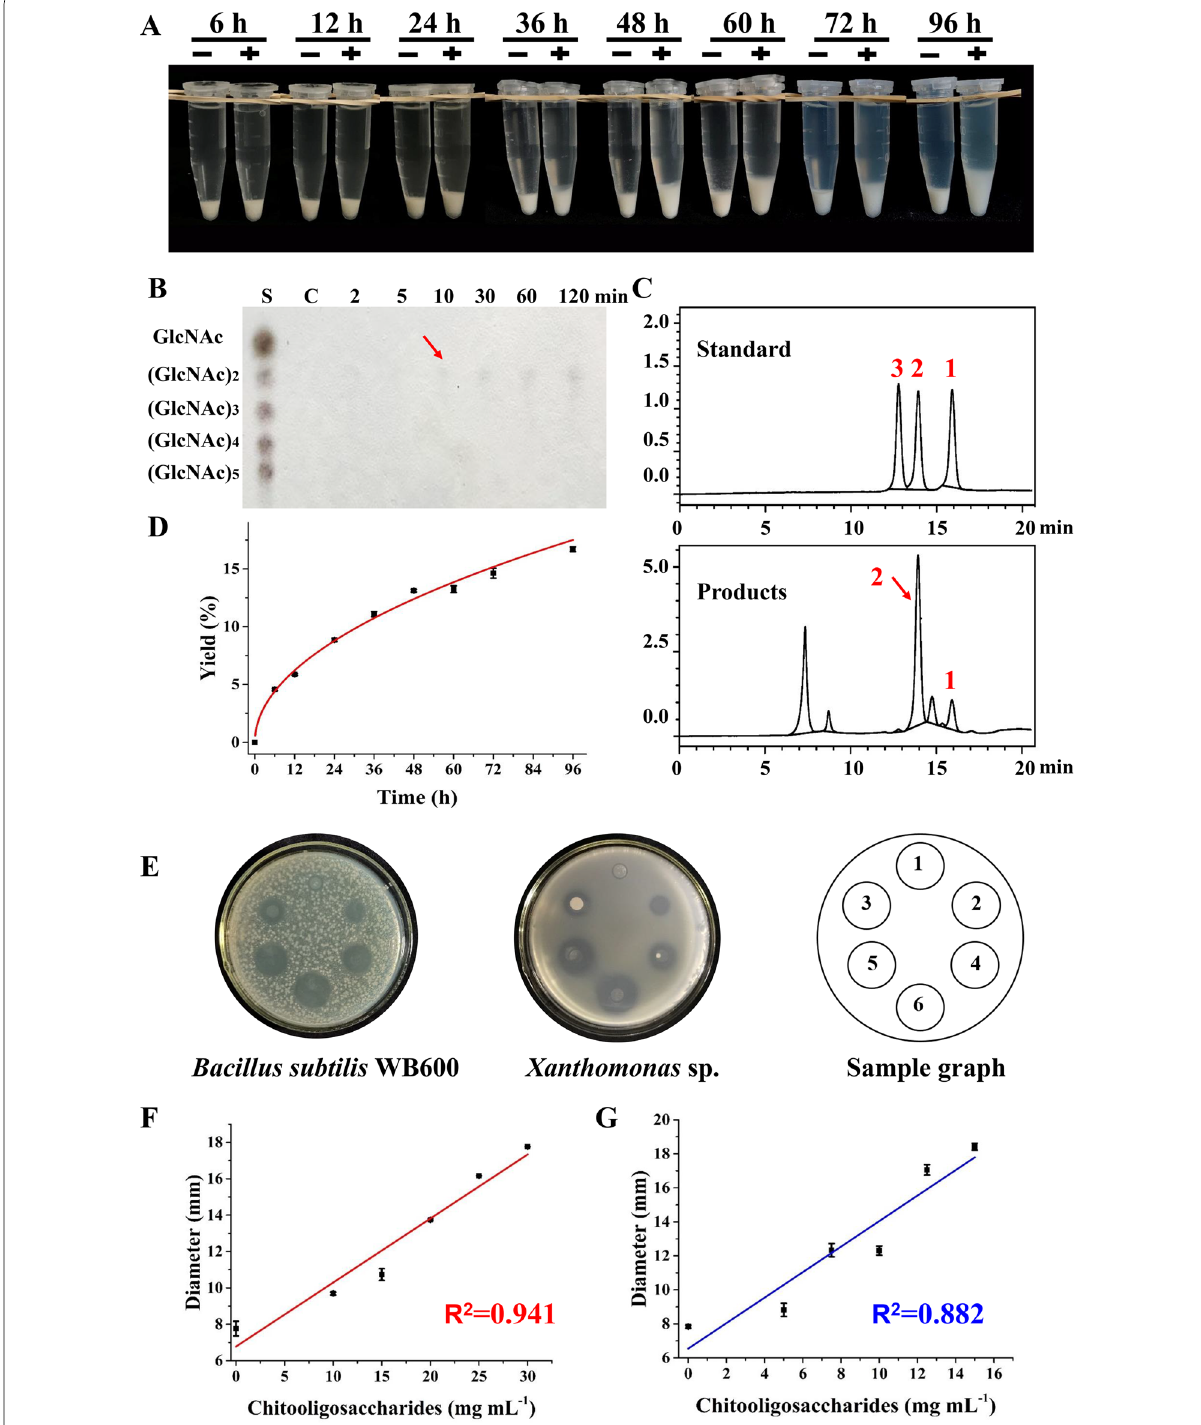
Fig. 5 Degradation of crude chitin powder by Chi304 and the antibacterial activity of the chitooligosaccharides products. A Accumulation of degraded crude chitin powder under exposure to Chi304. B TLC detection of crude chitin powder hydrolysis; S, 50 mg mL − 1 (GlcNAc) 1–5 mixed standard. C HPLC detection of crude chitin powder hydrolysis; standard, 1 mg mL − 1 (GlcNAc) 1–3 mixed standard. D Yields of reducing sugars produced by crude chitin powder degradation. E Zones of inhibition produced by different concentrations of chitosan oligosaccharides. Zones 1–6 had 0, 25, 50, 75, 100, and 125 mg mL − 1 chitosan oligosaccharides, respectively. F , G Linear relationship between chitosan oligosaccharide concentration and the diameter of inhibition zone for F B. subtilis WB600 and G Xanthomonas